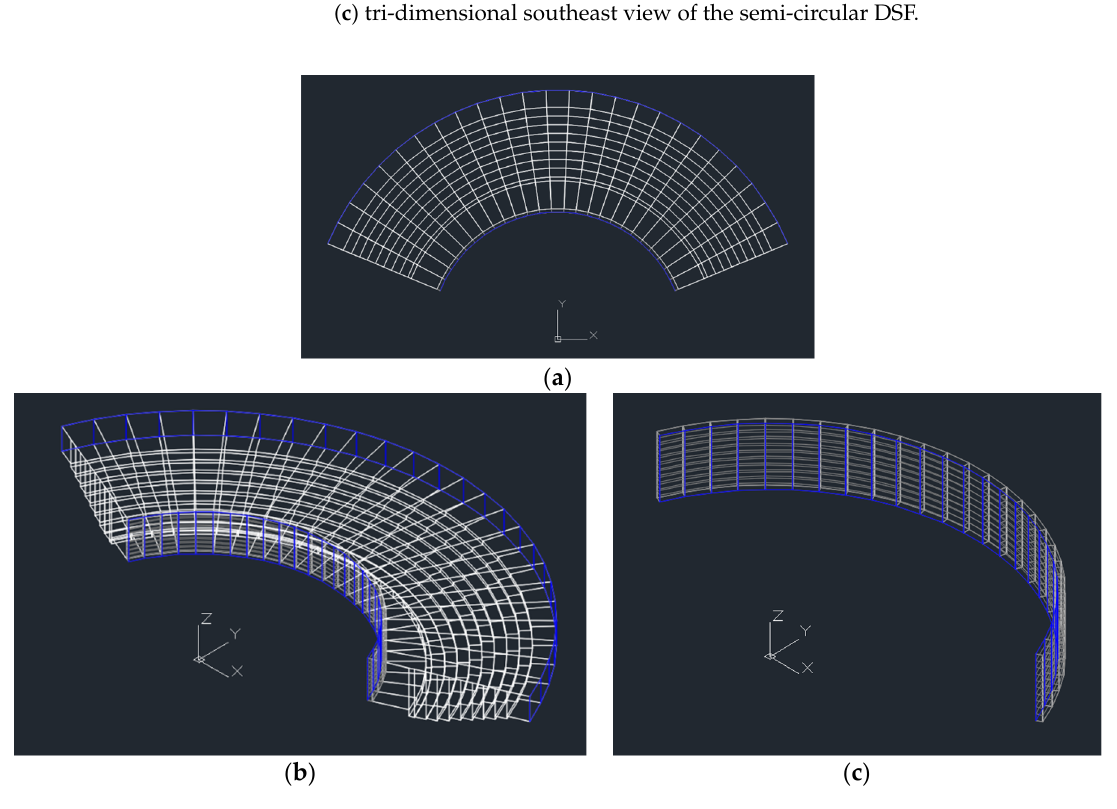
Figure 13. Virtual auditorium developed in Case E. ( a ) Top view of the auditorium and the semi- circular DSF, ( b ) tri-dimensional southeast view of the auditorium and the semi-circular DSF, and ( c ) tri-dimensional southeast view of the semi-circular DSF.